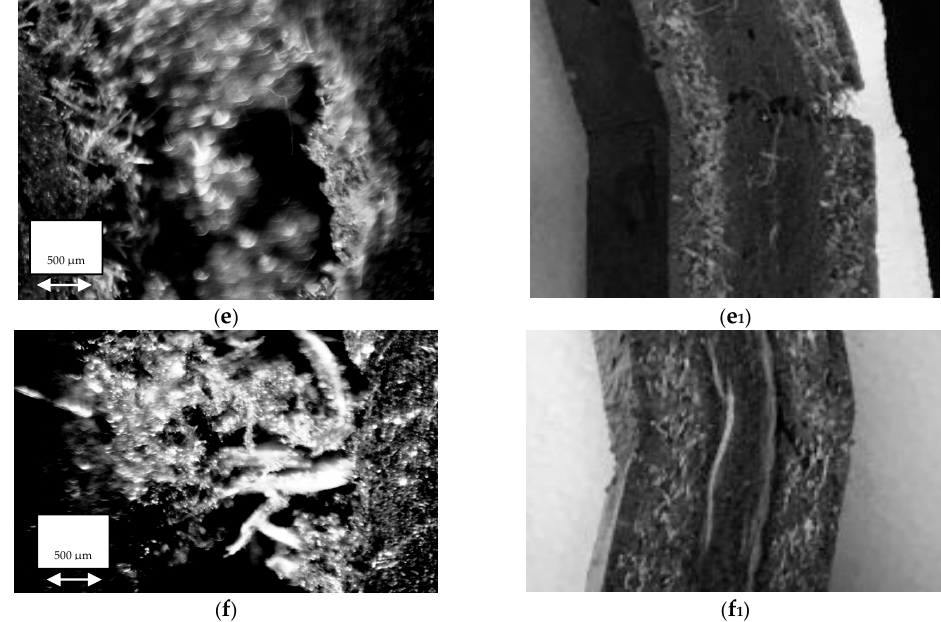
Figure 9. Light microscopy images captured from the tension side of all the flexurally broken samples. ( a , a 1 ) commercial glass (G’G’); ( b , b 1 ) glass (GG); ( c , c 1 ) only flax (F); ( d , d 1 ) hybrid flax and glass (FG); ( e , e 1 ) only hemp (H); and ( f , f 1 ) hybrid hemp and glass (HG).